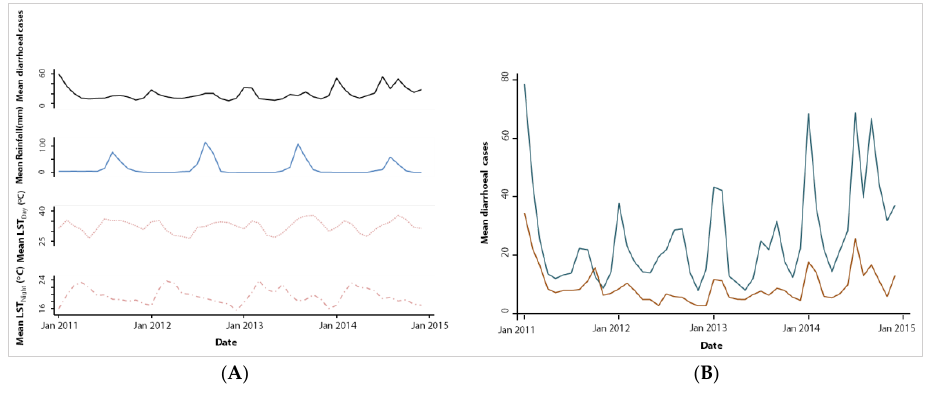
Figure 4. Trend in mean monthly mean diarrhoeal cases per health facility and climatic factors in the health district of Mbour over a four-year period from 2011 to 2014. ( A ) Trend in monthly mean diarrhoeal cases per health facility with mean rainfall, mean LST Day and LST Night ; ( B ) Trend in mean monthly diarrhoeal cases per health facility in urban and rural settings. Table 5. Effect of season on the number of visits of health care centred due to diarrhoea in the health district of Mbour, Senegal from